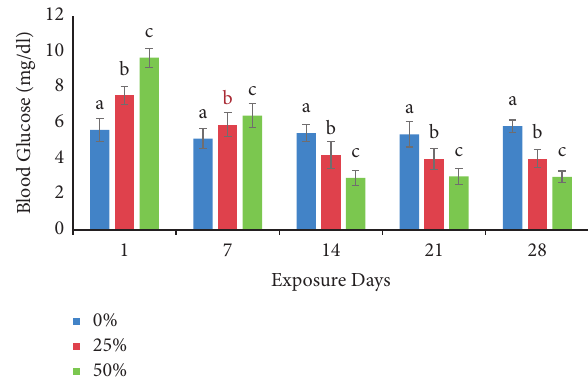
Figure 3: Effects of sublethal exposure of malathion on glucose level (mean ± SD) at different time intervals in silver barb. Different superscript letters are significantly different at p < 0 .